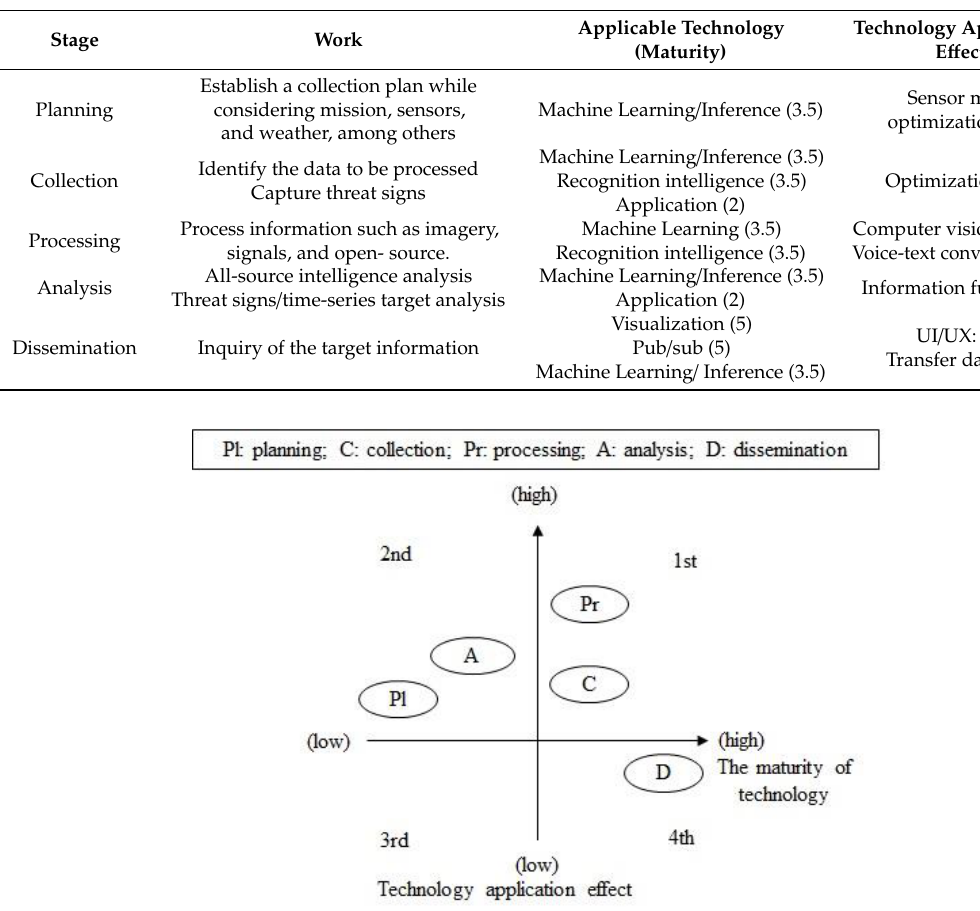
Table 5. Applicable technology and application e ff ect by military intelligence areas.